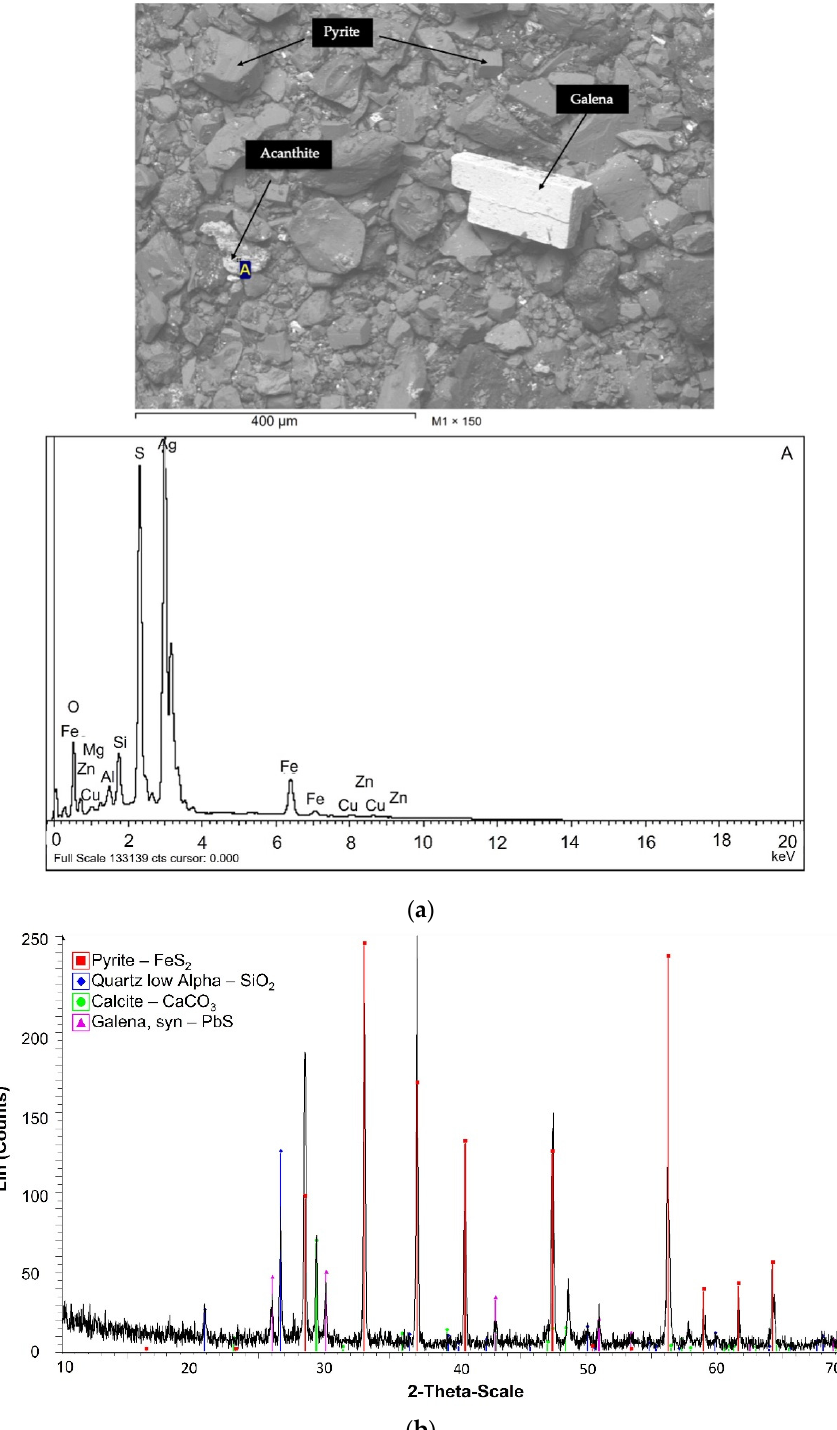
Figure 2. ( a ) Scanning electron microscopy of the sample at 400 μ m showing pyrite, argentite, and galena particles, and energy dispersive X ‐ ray spectroscopy images of particles. ( b ) X ‐ ray diffraction pattern of concentrate sample.